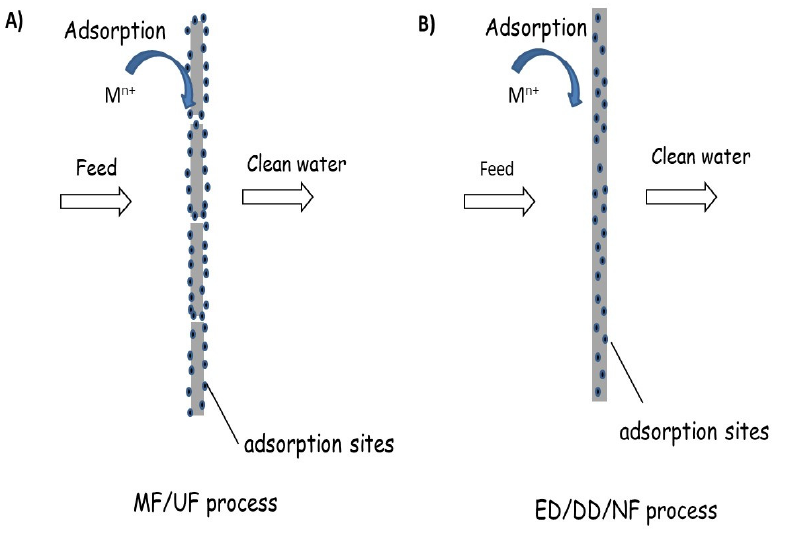
Figure 5. Classification of adsorptive membranes and corresponding separation processes: ( A ) membranes with functionalized pores and ( B ) dense/nanoporous membranes with entrapped adsorption sites.